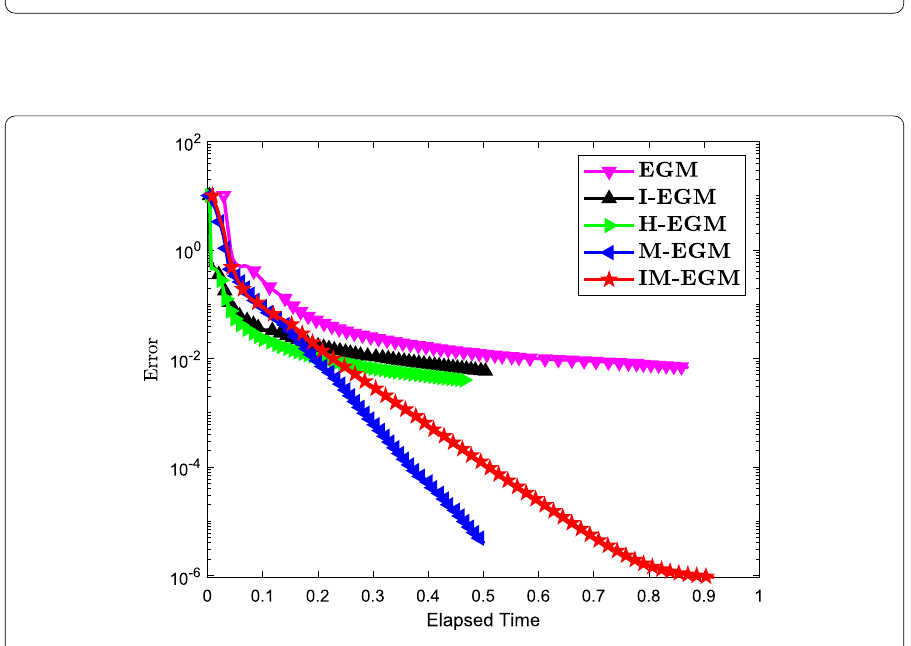
Figure 14 Numerical comparison of Algorithm 1 and Algorithm 2 using Algorithm 1 in [52], Algorithm 2 in [51], and Algorithm 1 in [18], while s 0 = s 1 = sin( t ) for the first 500 iterations